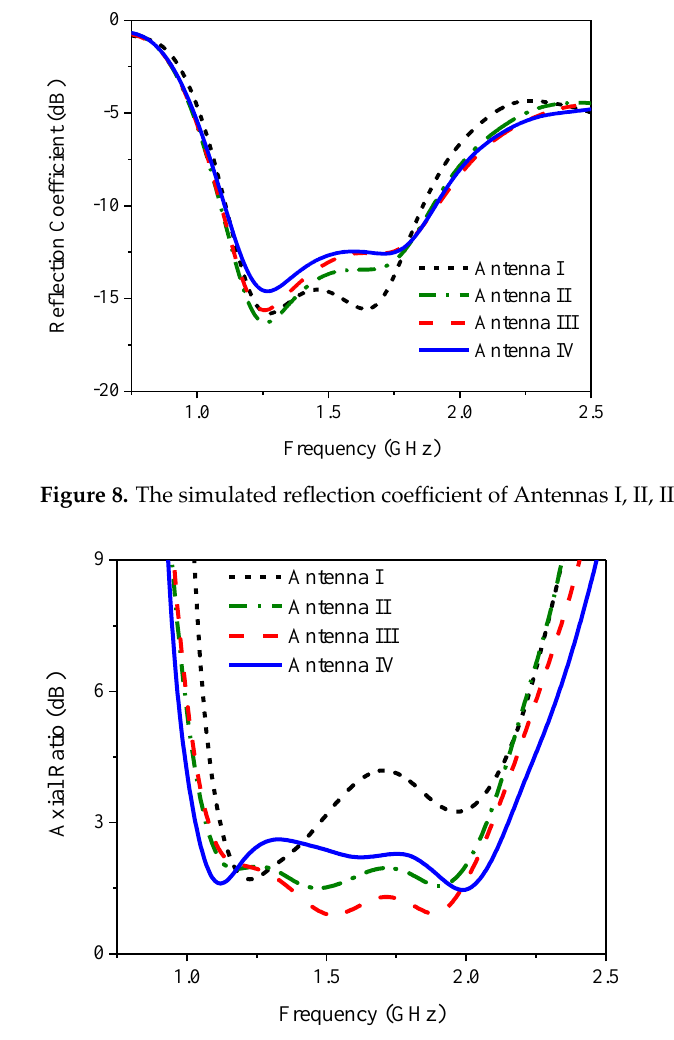
Figure 9. The simulated axial ratio of Antennas I, II, III and IV. The simulated RLBW and ARBW of Antenna III were 54.66% (1.09–1.91 GHz) and 64.55% (1.07–2.09 GHz). In Figure 9, the solid square branch of Antenna III rendered AR close to 1 dB in the upper L-band (1.5–2.0 GHz). The low AR ( ≤ 1 dB) was attributable to the larger surface area of the solid square branch, vis- à -vis the square ring branch (Antenna II). The larger surface area mitigated the coupling effect between the inverted L-shaped ra- diating patch and the adjoining branch (Figure 10). In Antenna IV, the simulated RLBW and ARBW were 53.12% (1.106–1.906 GHz) and 70.88% (1.02–2.14 GHz). The triangular corner truncation of the partial ground plane enhanced the ARBW from originally 64.55% (Antenna III) to 70.88%. The enhanced ARBW rendered Antenna IV suitable for a wide range of L-band